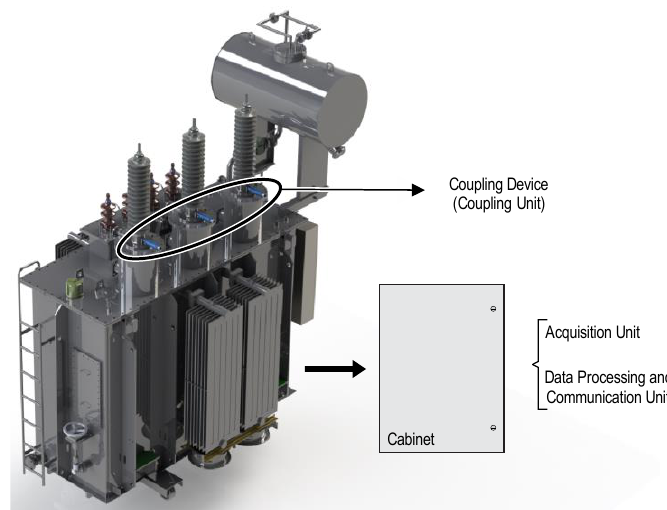
Figure 3. Structure of an online monitoring system.